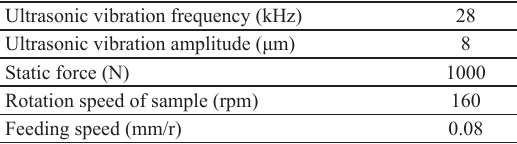
Table 4. USRP experimental process